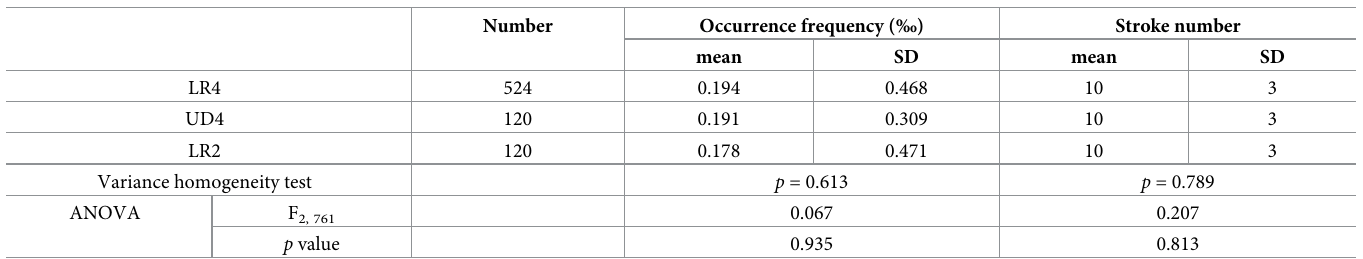
Table 1. The occurrence frequency and the stroke number of the